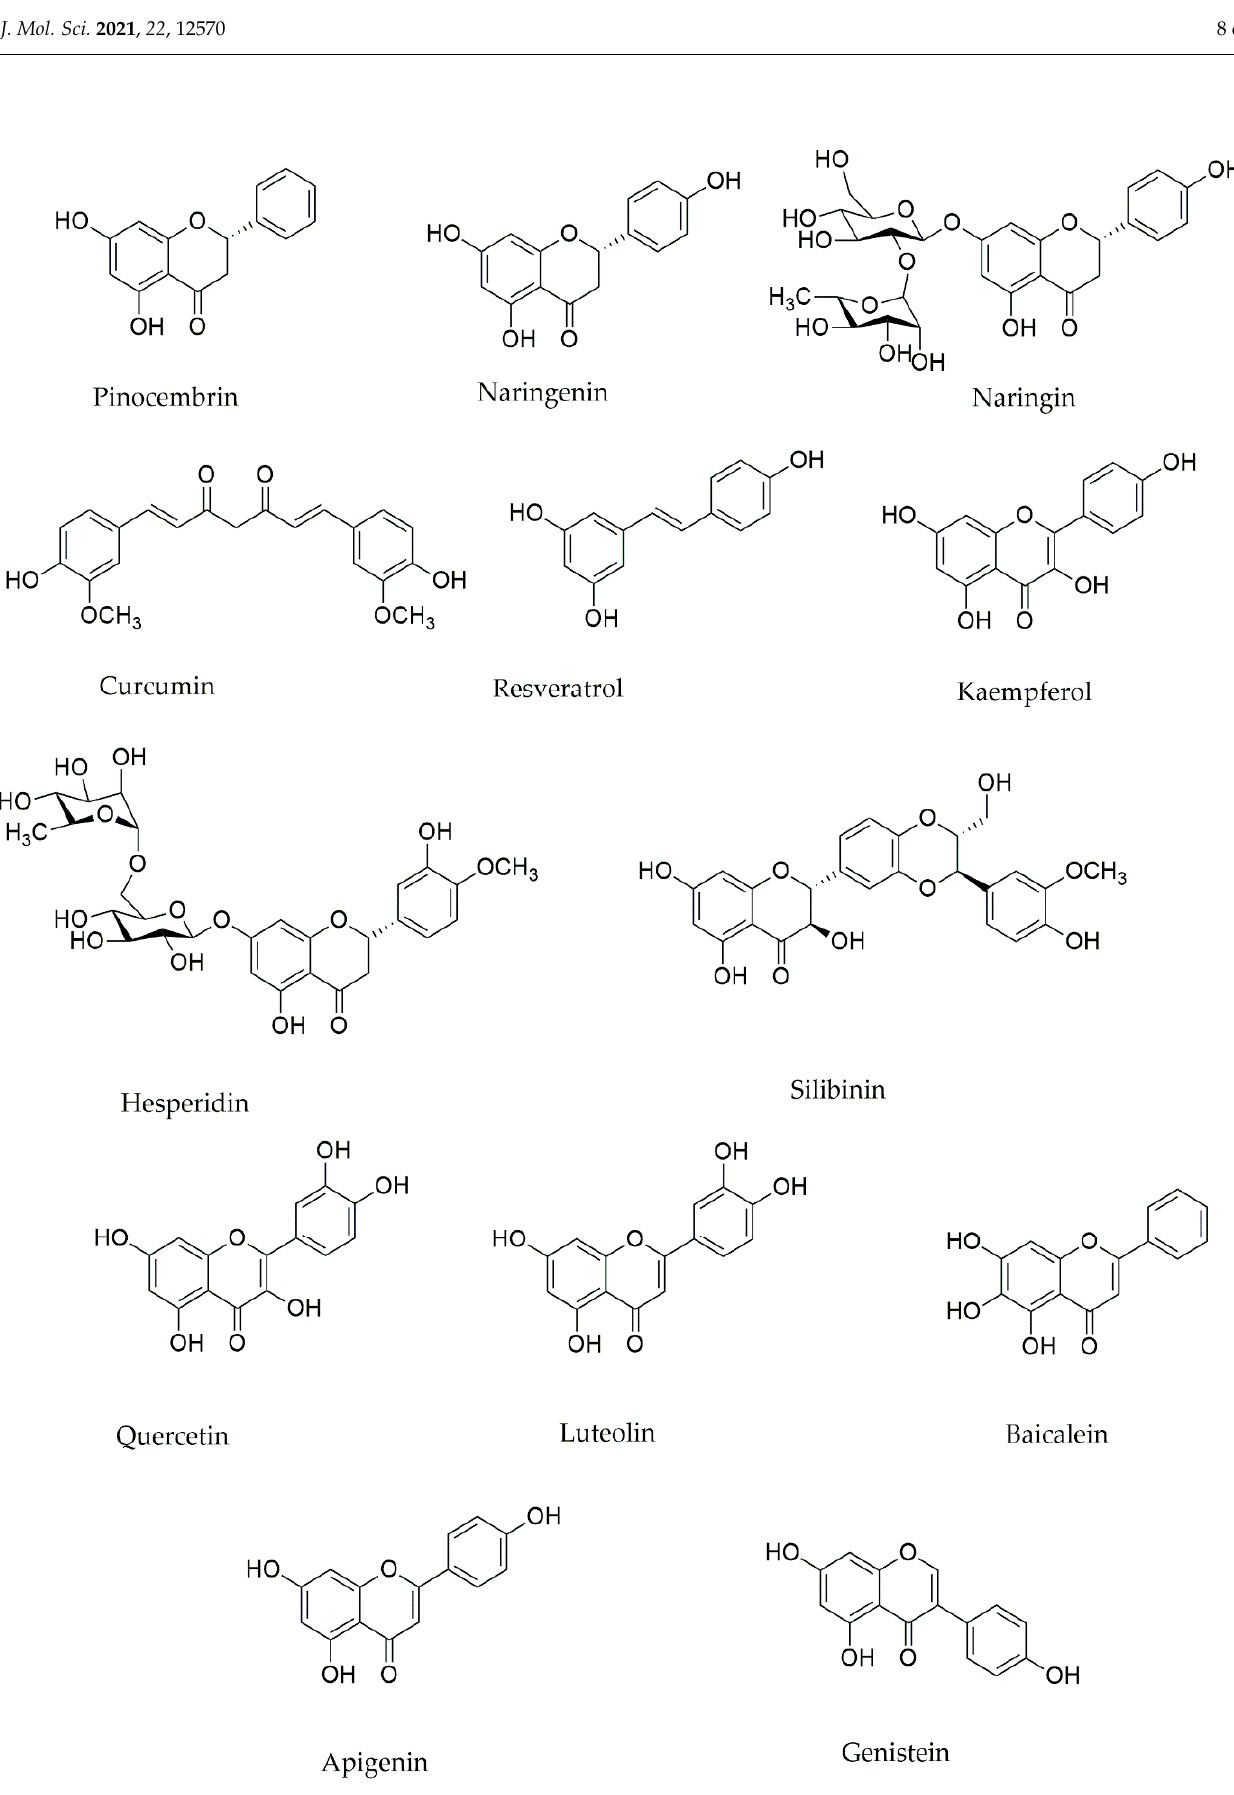
Figure 2. The chemical structure of flavonoids/phenolic compounds.